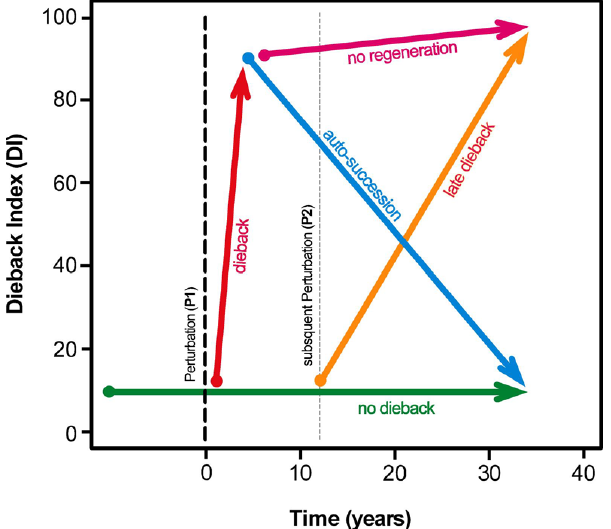
Fig.11: Change of dieback index DI (proportion of dead or dying Metrosideros canopy trees 635 Fig. 11. Change of dieback index DI (proportion of dead or dy- per forest stand/cohort) over time, based on the results of > 30 years of permanent plot assessment in Hawaii´s montane rainforest (Boehmer et al., in press). Bold dashed line: major climatic Hawaii’s montane rainforest (Boehmer et al., 2013). Bold dashed line: major climatic perturbation (dieback trigger). Green arrow: perturbation (dieback trigger). Green arrow: stands not affected by dieback; red arrow: stands (old stands not affected by dieback; red arrow: stands (old cohorts) af- fected by dieback; blue arrow: stands regenerating after dieback cohorts) affected by dieback; blue arrow: stands regenerating after dieback (auto-succession); pink (auto-succession); pink arrow: stands not regenerating due to ’¯ohi’a arrow: stands not regenerating due to ` ō hi`a life cycle disruptors; orange arrow; cohorts affected by a 640 life cycle disruptors; orange arrow: cohorts affected by a subsequent perturbation (thin dashed line). subsequent perturbation (thin dashed line).